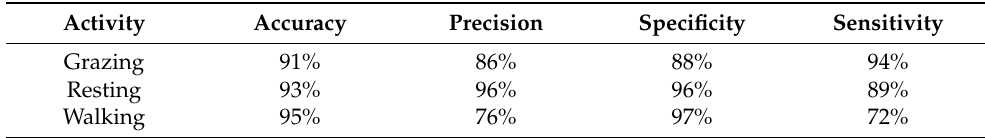
Table 5. Performance metrics of random forest classifier algorithm for grazing, resting, and walking activities of ewe lambs. Activity Accuracy Precision Specificity Sensitivity